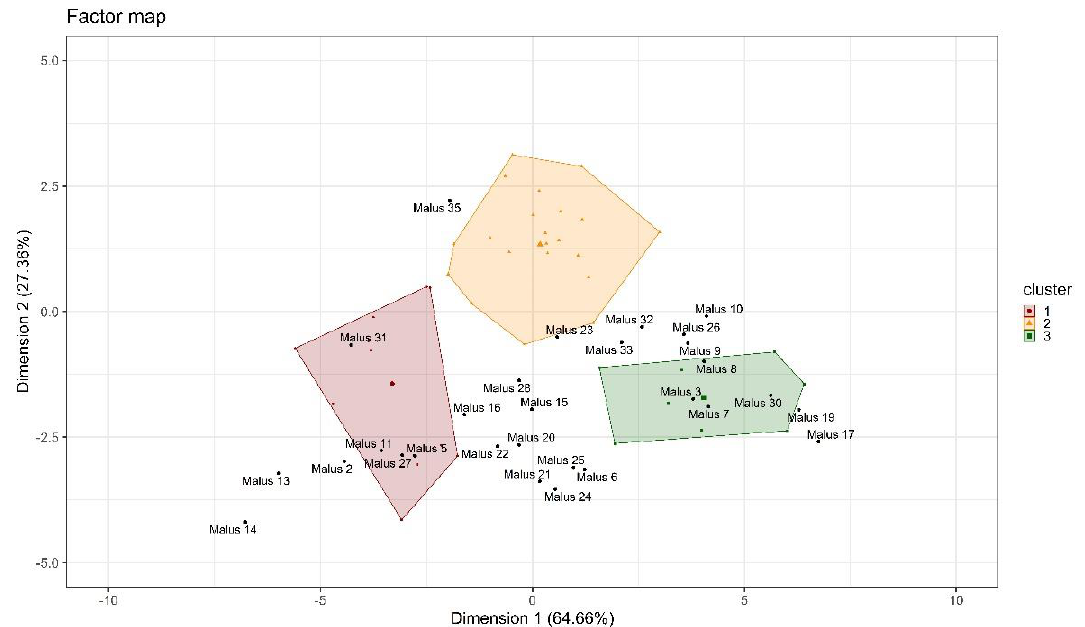
Figure 7. Factorial map of individuals projected according to their position based on 12 variables. Red (cluster 1), yellow (cluster 2), and green (cluster 3) points represent the observations of the initial clustering. Predicted projections of new observations (black) based on the initial PCA.